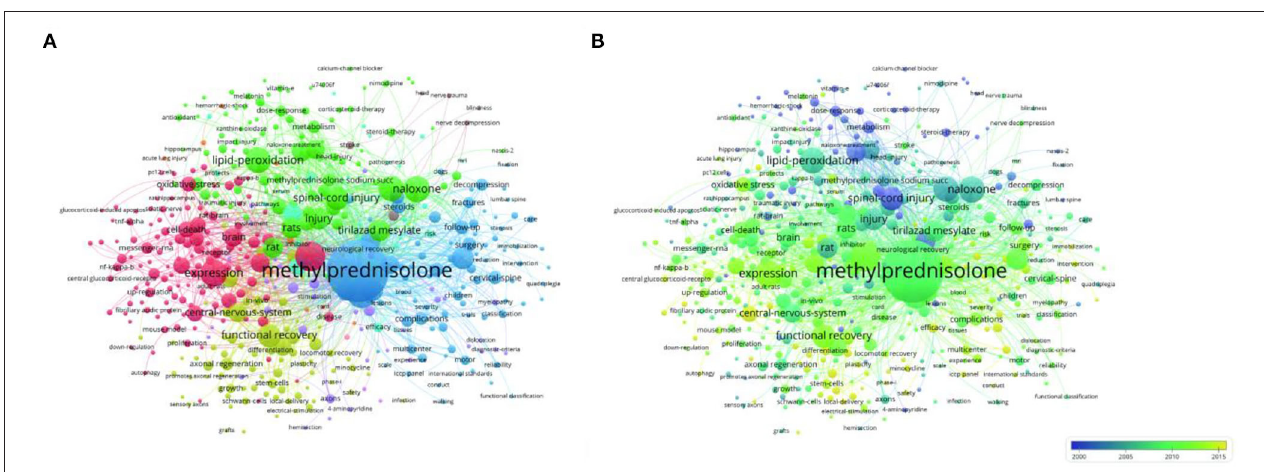
FIGURE 7 | (A) Distribution of the themes. The yellow cluster represents studies of recovery of nerve function. The blue cluster indicates diagnosis and clinical features. The red cluster involves molecular regulatory mechanisms. (B) Average year map of keywords used from 1982 to 2022.